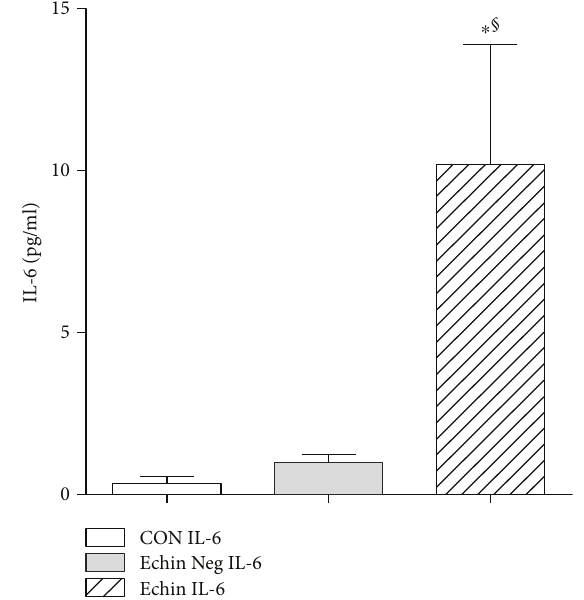
Figure 2: Serum levels of IL-6 in the group of infected patients (Echin IL-6) are signi fi cantly increased ( p < 0 05 ) in comparison to the IL-6 concentration evaluated in the group of Echinococcus - negative patients (Echin Neg IL-6) and the group of control subjects (CON IL-6). ∗ p < 0 05 versus CON; § p < 0 05 versus Echin Neg, after ANOVA and Fisher PLSD test.